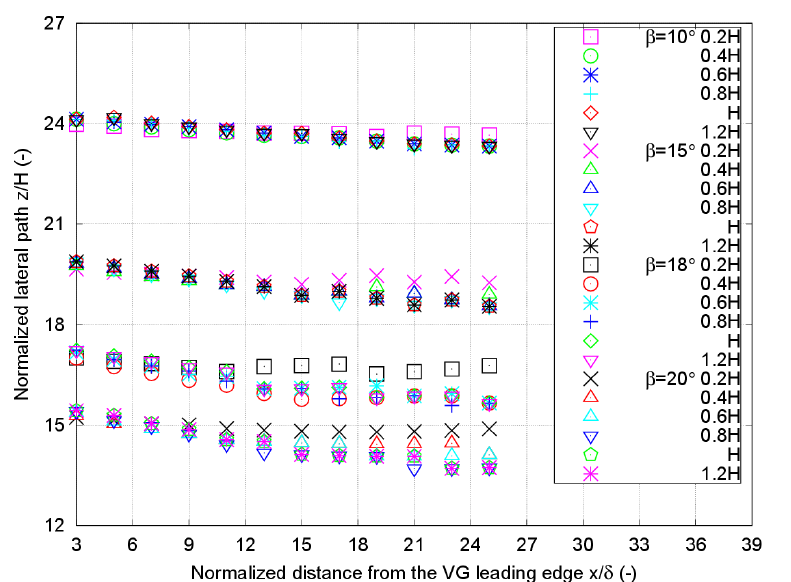
Figure 4. Normalized lateral position of the vortex center as a function of the axial distance x of the VG for six VG heights, 0.2H, 0.4H, 0.6H, 0.8H, H, and 1.2H, and four different incident angles β